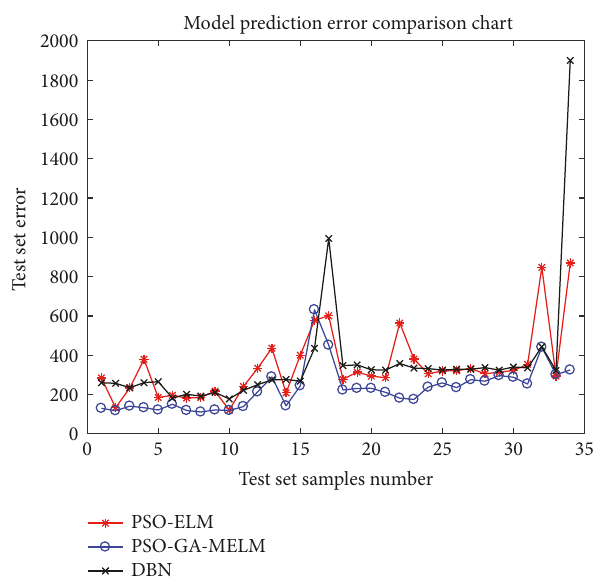
Figure 7: Average testing error for the algorithms PSO-ELM, PSO-GA-MELM, and